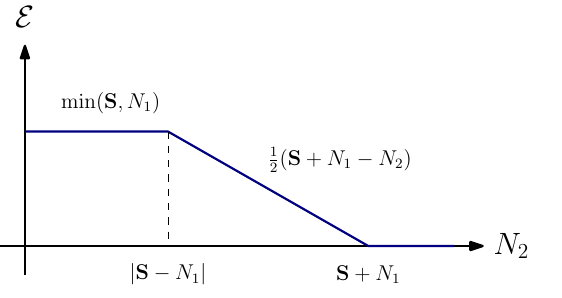
Figure 29 . Equivalent one-tensor network diagrammatic representation of figure 28.